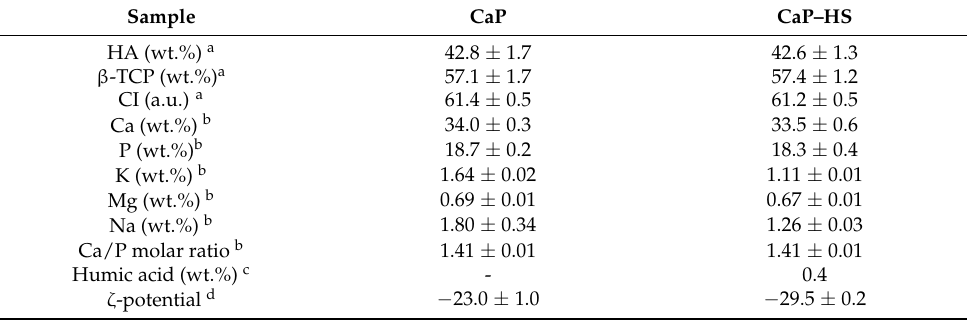
Table 1. Phase, chemical composition and surface charge of the samples.